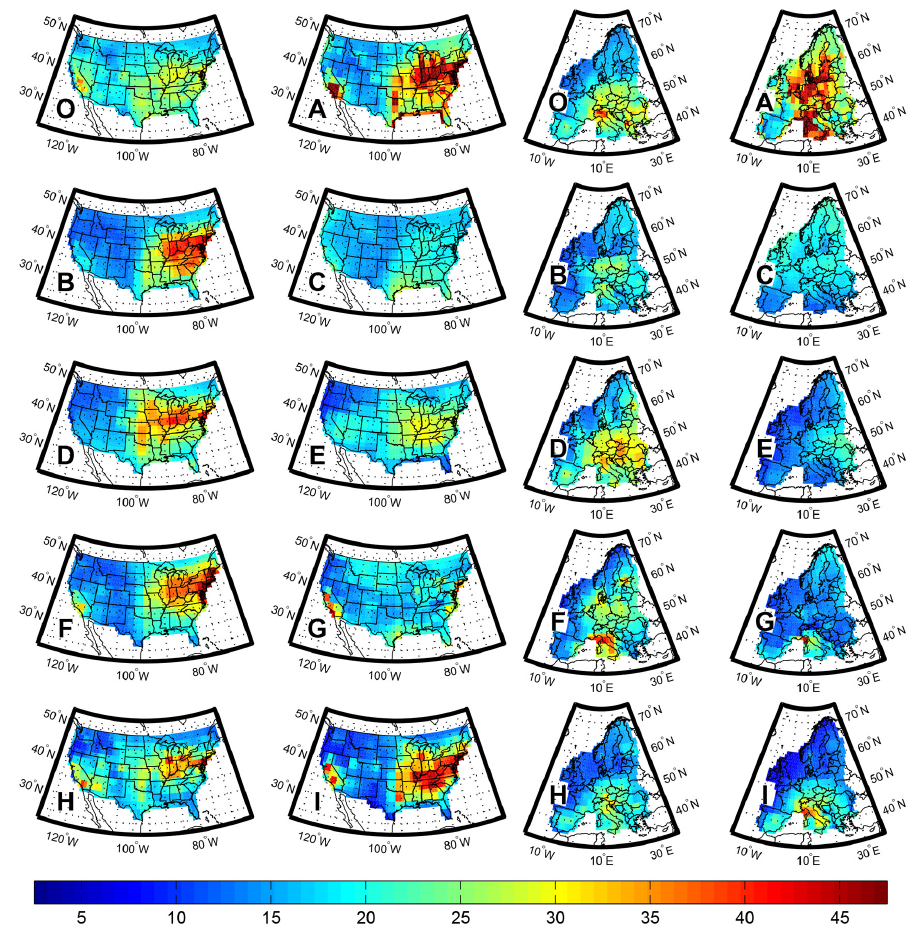
Figure 3. Summertime O 3 enhancement E JJA is the difference between the 87th and 30th percentile of the gridded surface MDA8 O 3 (ppb) over (left two columns) NA and (right two columns) EU for the observations (O), ACCMIP models (A–H), and UCI CTM (I). The values of model I are scaled by 0.5 so the same color scale can be